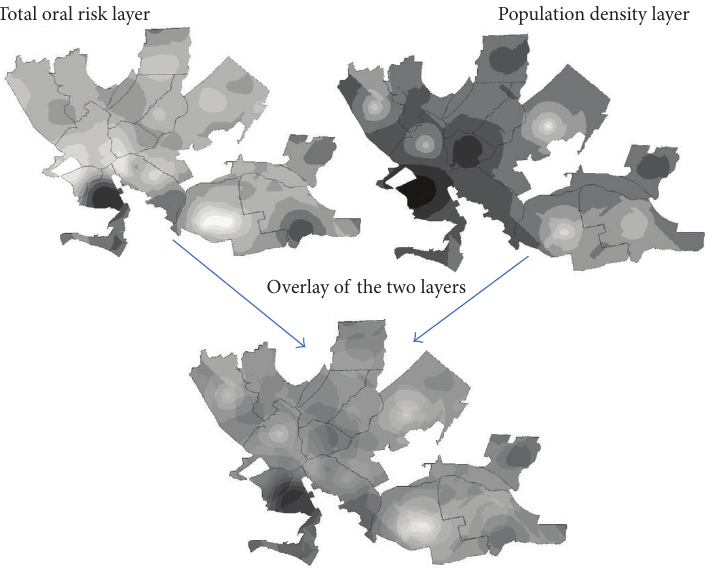
F 3: Overlay model of the